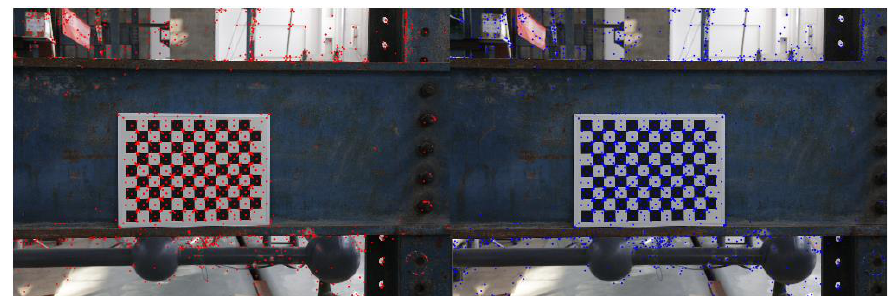
Figure 1. Expression of feature points in two images.